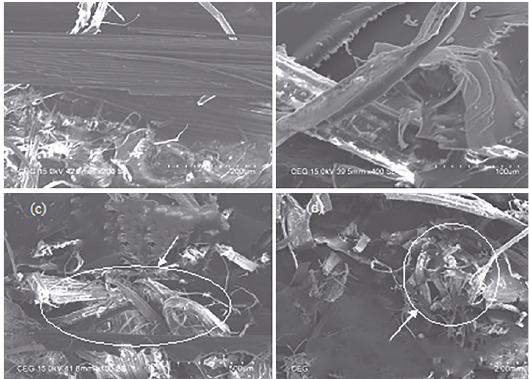
Figure 21: SEM micrographs of carbon/banana fiber composites subjected to water intake